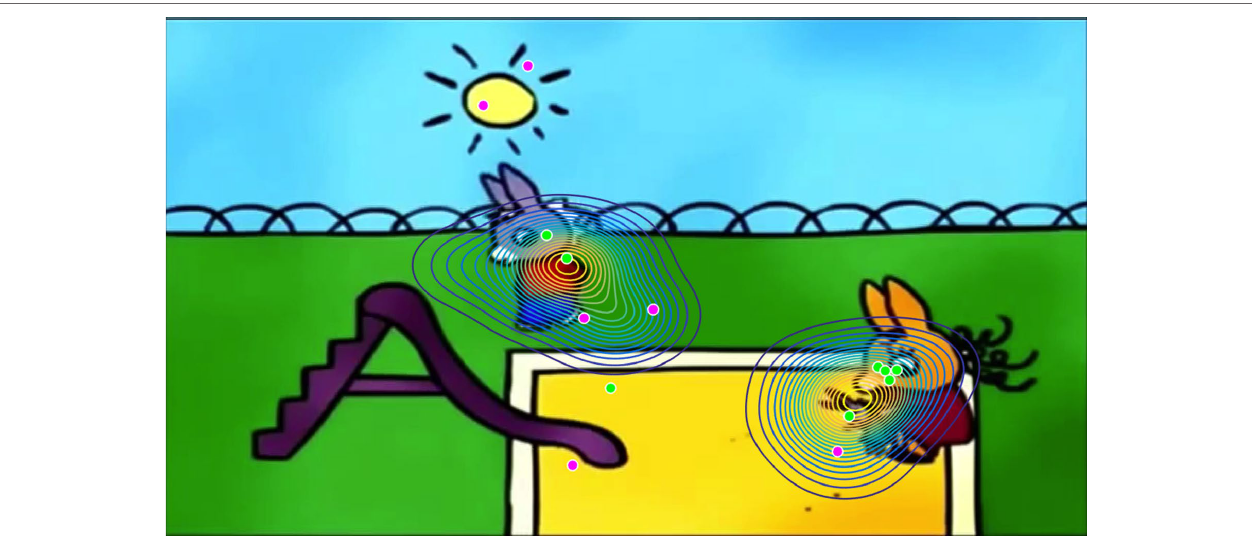
FIGURE 1 | A video still from a “Trotro” cartoon film illustrating the position of the “norm” in gaze, which was established using a kernel density distribution estimation on gaze data from a group of 26 typically developing children aged 2–5 years (represented here with contour plots). For this particular frame, the gaze of typically developing children was split into two foci of interest, centered on the main characters. The gaze of each child with autism spectrum disorder (ASD) in this sample is demonstrated with individual dots. Green dots represent gaze coordinates of control-similar (CS) children with ASD (n = 8), while pink dots represent gaze coordinates of control-dissimilar (CD) children with ASD (n = 6). It is important to note that the subgrouping into CS and CD children with ASD is based on average gaze data from the entire movie. Therefore, it follows that for this specific frame, two CD ASD children, whose gaze patterns were, on average, far from the “norm” over the course of the movie, were focusing closer to the center of attention of TD children than one CS ASD